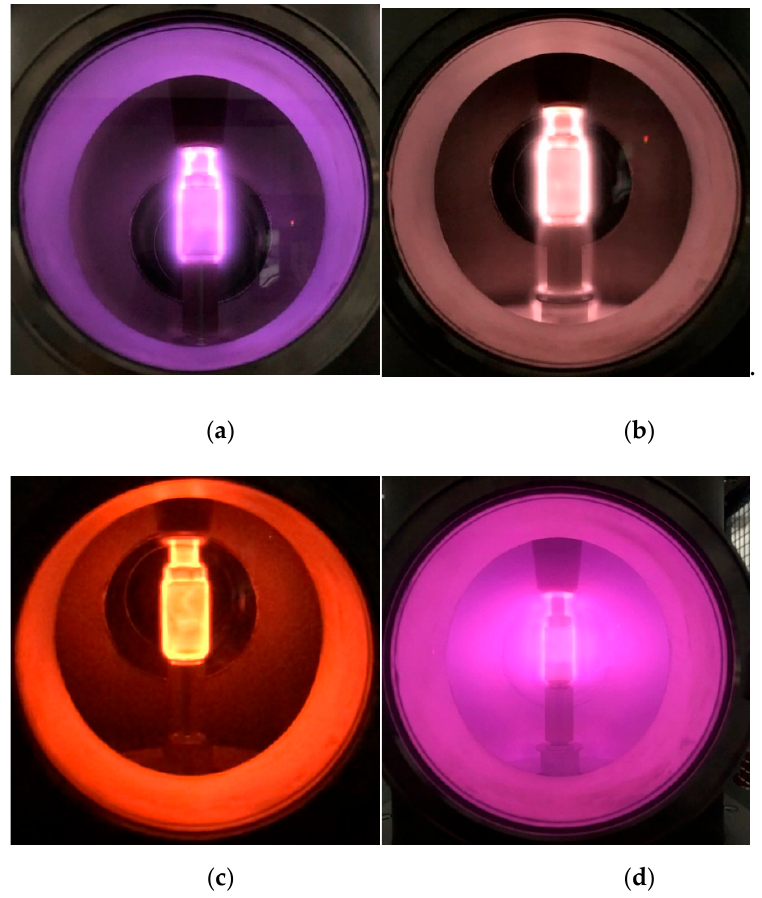
Figure 8. Light emitted in the discharge chamber when glow discharges occur for residual gases: ( a ) argon, ( b ) helium, ( c ) neon, ( d ) air.